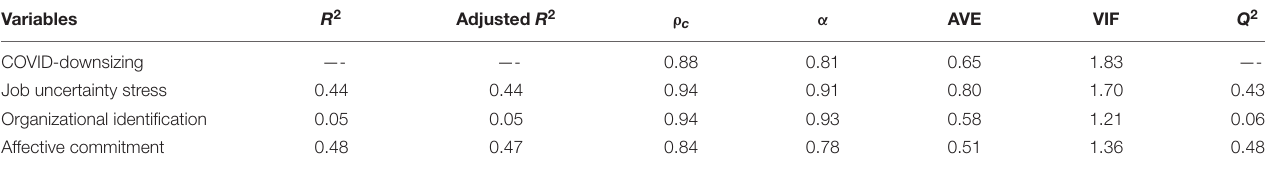
TABLE 1 | Latent variable estimates.